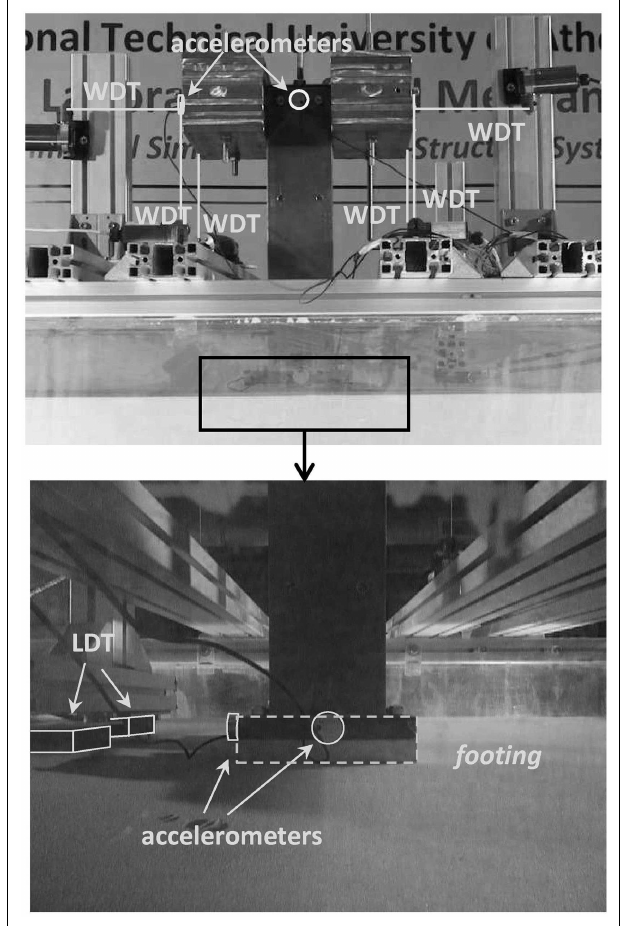
FIGURE 4 | Photos showing the instrumentation